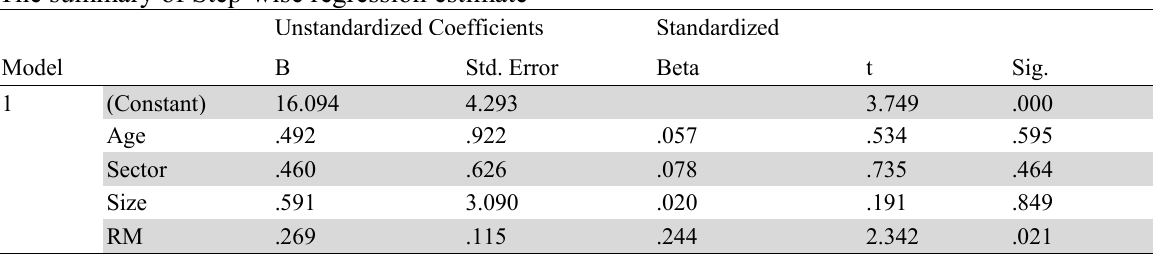
The summary of Step-wise regression